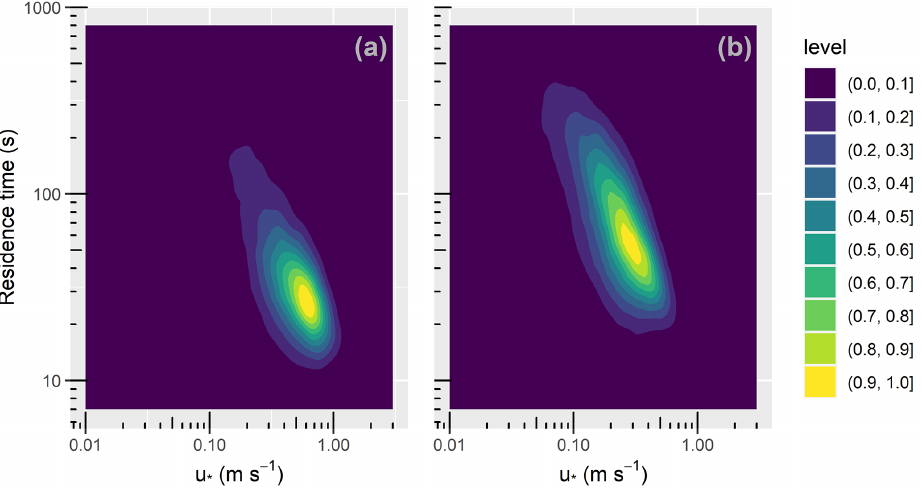
Figure 6. Two-dimensional density plots, showing the variation of the residence time, τ (Sect. 2.3), with the friction velocity, u ∗ (Sect. 2.5), for the (a) leaf-off and (b) leaf-on periods (Sect. 2.2 for observation details). The colour scale is normalised to account for the different sample sizes in the two periods. “Level” in the colour scale refers to the density of each bin, normalised by the peak density for each observational period.